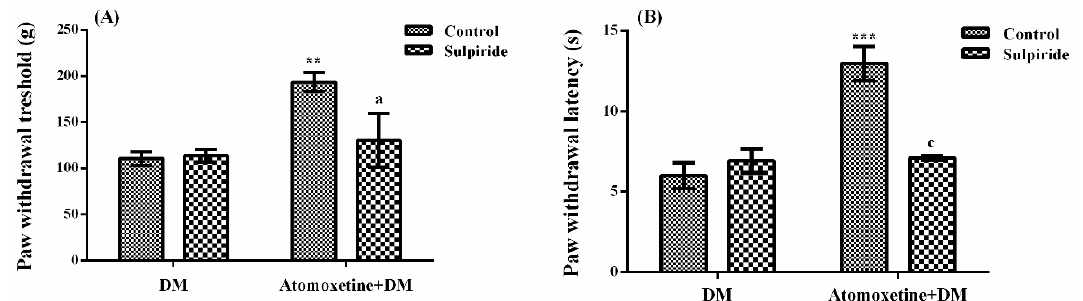
Figure 7. Effects of sulpiride pre-treatments on the antihyperalgesic responses induced by atomoxetine (3 mg/kg, 14 days) against mechanical ( A ) and thermal ( B ) nociceptive stimuli applied in the Randall-Selitto and Hargreaves tests, respectively. Values are given as mean ± S.E.M. Significant difference against physiological saline administrated diabetic group (DM) is ** p < 0.01; *** p < 0.001; Significant difference against atomoxetine administrated diabetic groups (Atomoxetine+DM) are a p < 0.05 and c p < 0.001. Two-way repeated ANOVA, post hoc Bonferroni test, n =